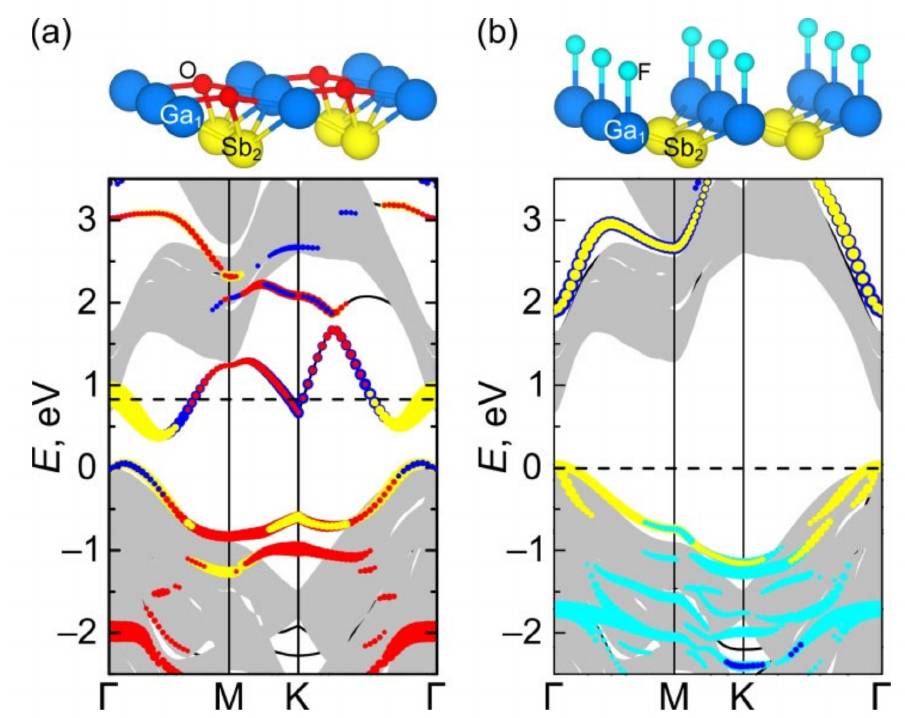
Figure 6. Atomic structure (3D view) and electron energy spectrum in the case of GaSb(111) Ga surface with O adatom in Ga-B site ( a ) and with F adatom in Ga-T site ( b ). The surface states localized on Ga 1 , Sb 2 , O, and F atoms are shown by blue, yellow, red, and cyan balls, respectively. The denotations of the zero energy, the bulk states, the Fermi level, and the size of balls are the same as in Figure